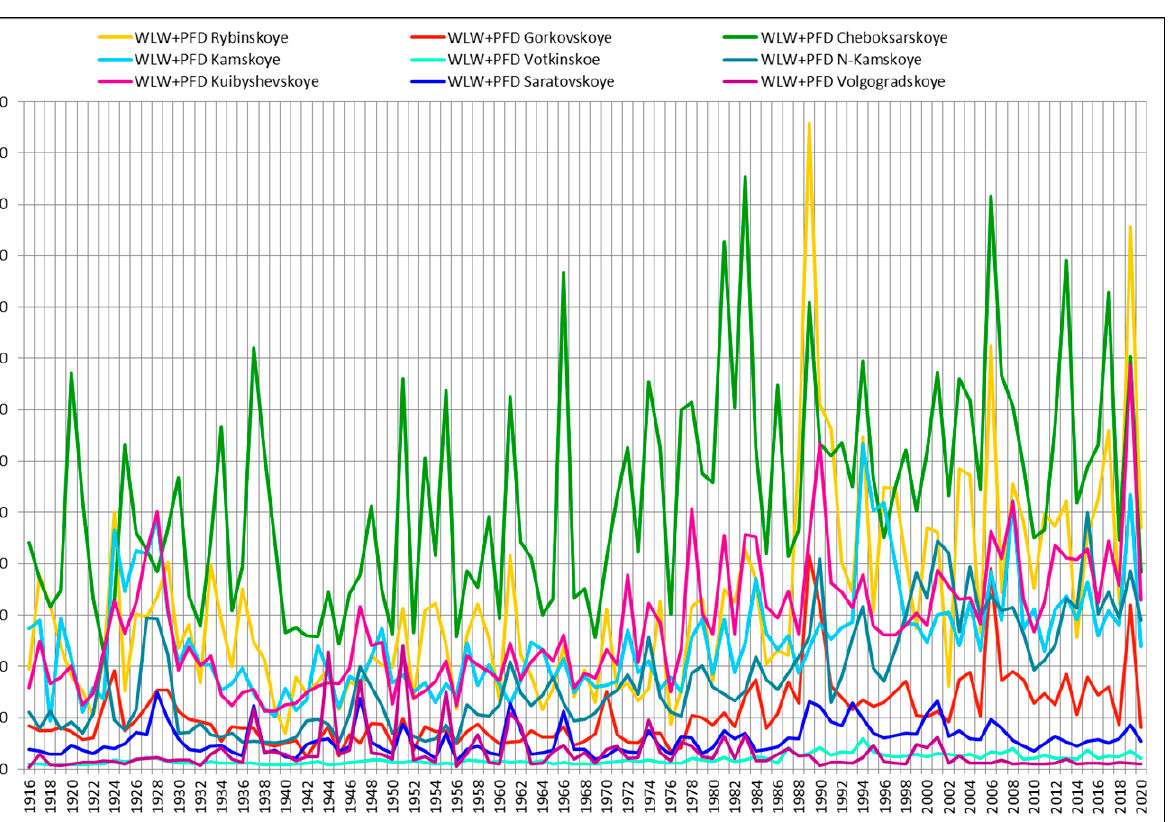
Figure 5. Long-term hydrological series of observed inflows to the VKC reservoirs in period WLW and PFD.